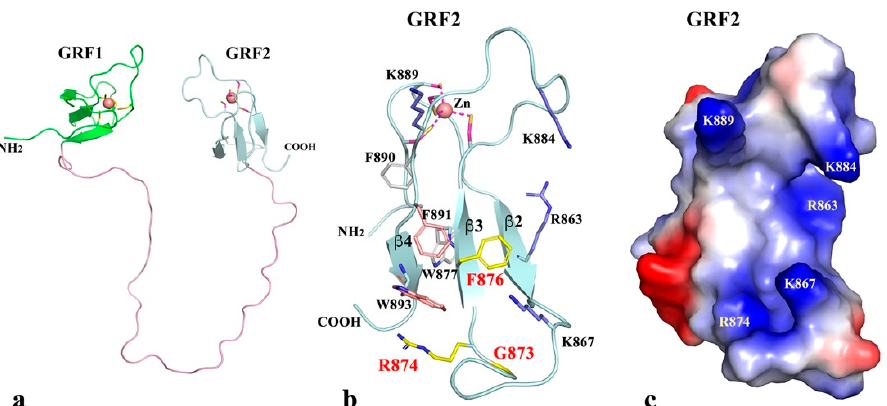
Figure 6. Predicted structures of zf-GRF repeats in the C-terminal region of P. graminis f. sp. tritici topoisomerase III. ( a ) Predicted structures for the two zf-GRF domains (GRF1 and GRF2) connected with a 40 residue linker. ( b ) A ribbon diagram of GRF2 domain. Besides the four cysteines that form the Zn 2+ -binding site, other key residues (including the signature GRxF motif labeled in red) that may contribute to domain folding and DNA-binding are drawn in stick format for highlighting. ( c ) Electrostatic surface potential representation of GRF2.